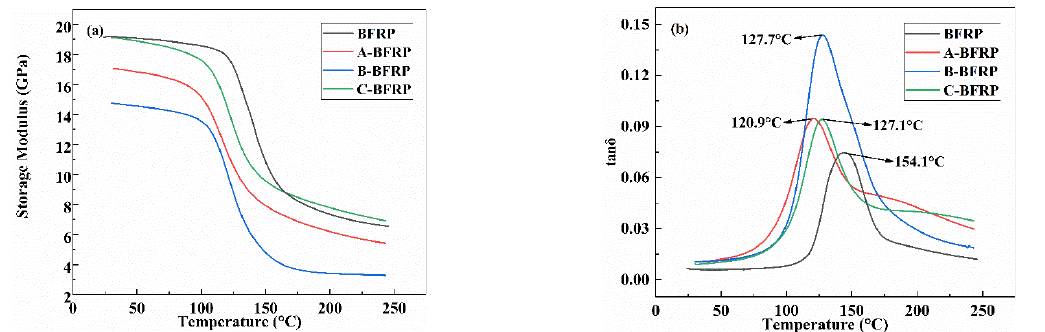
Figure 4. DMA of basalt fiber/epoxy resin composites: ( a ) storage modulus; ( b ) tan δ .